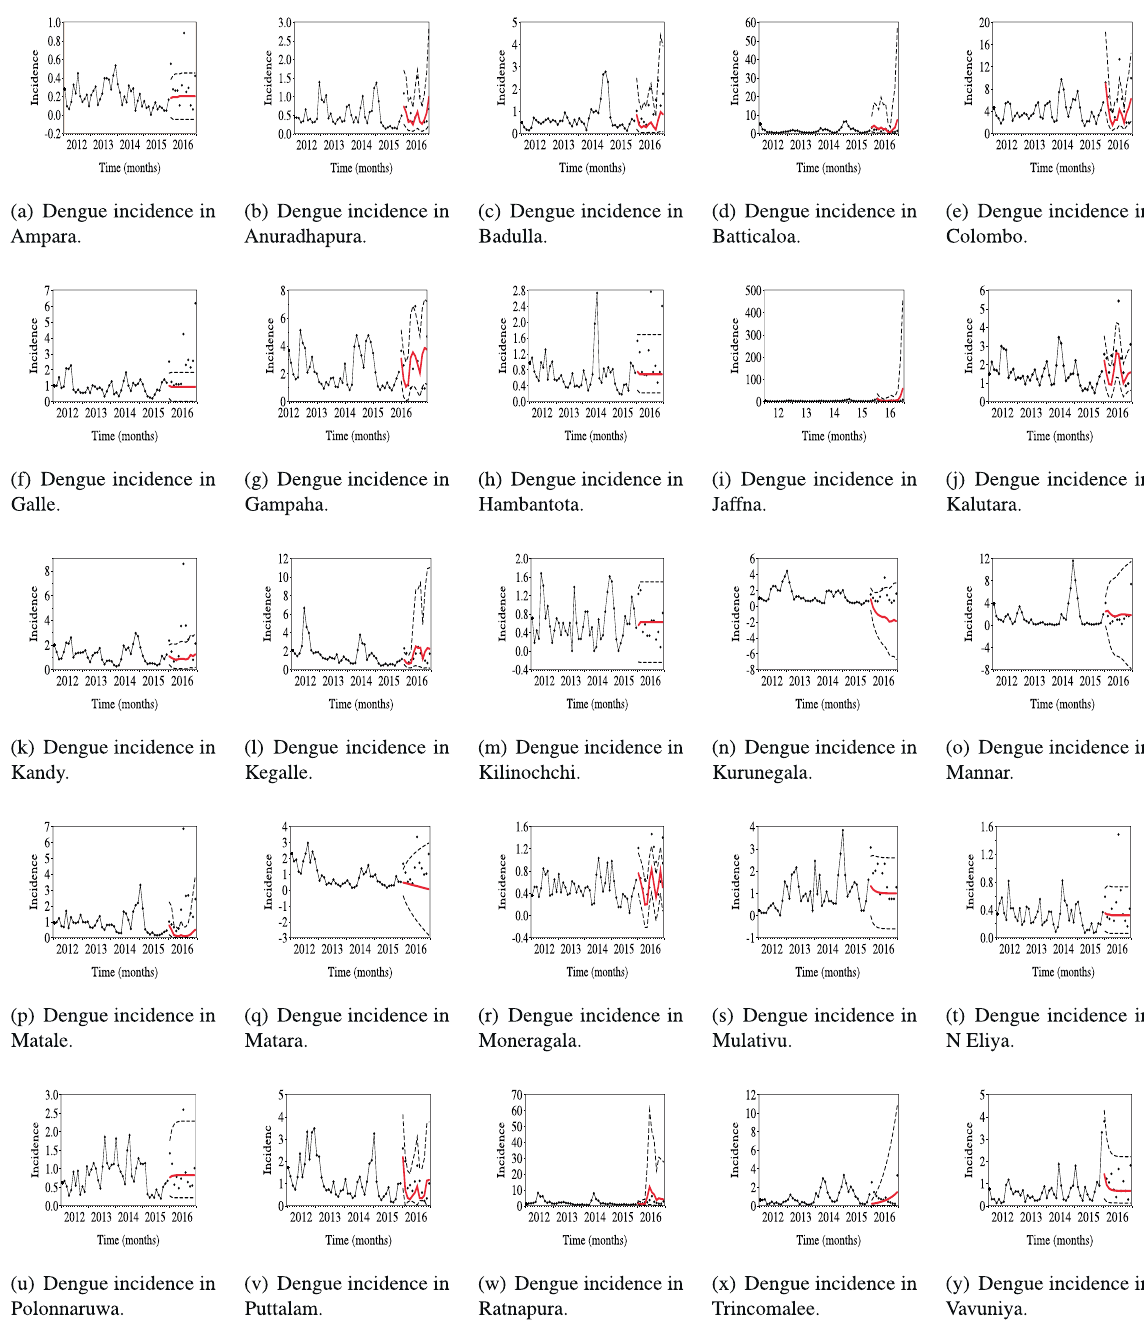
Figure 1. Annual dengue incidences for 25 districts of Sri Lanka from 2012 to 2016. We predicted dengue incidences for 2016 with dengue incidence data from 2012 to 2015 and meteorological data for 2016. The ∙ represents incidence data, the red lines represent the predicted data, and the dotted lines represent the confidence